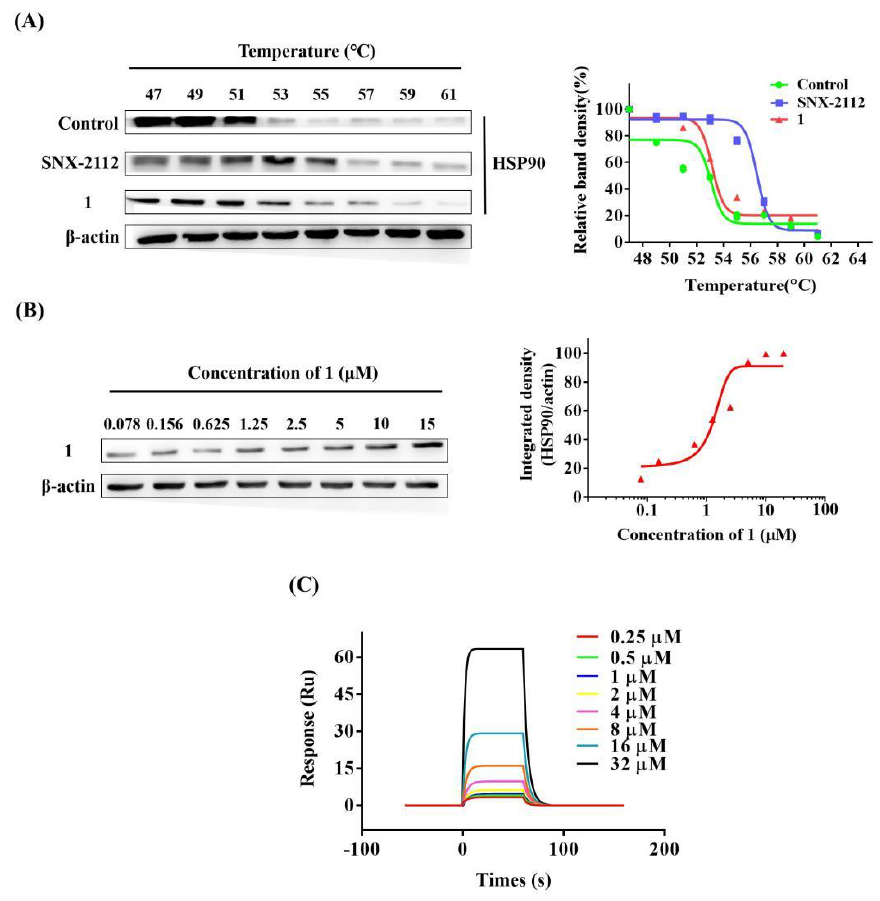
Figure 11. HSP90 α was the direct target of 1 . Compound 1 bound directly to HSP90 in CESTA assay ( A ), and the binding was dose dependent ( B ). Real time binding affinity measurements of 1 ( C ) further demonstrated the direct target was HSP90 α.